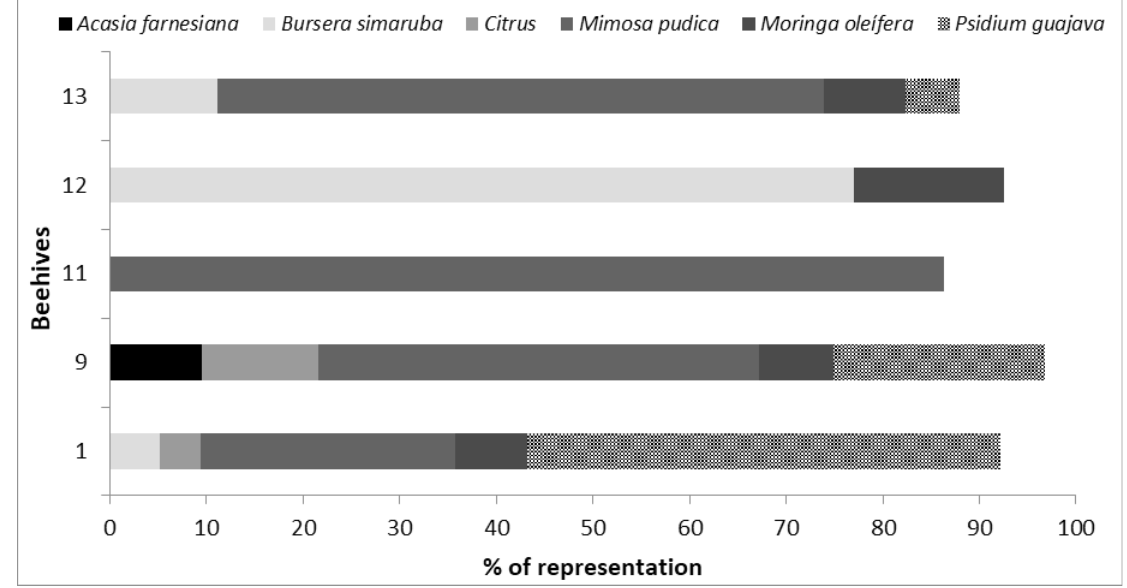
Fig 3 . Main floral resources identified in the pollen collected from Matanzas province. Dominant pollen (>45%), companion or secondary pollen (16-45%), isolated pollen